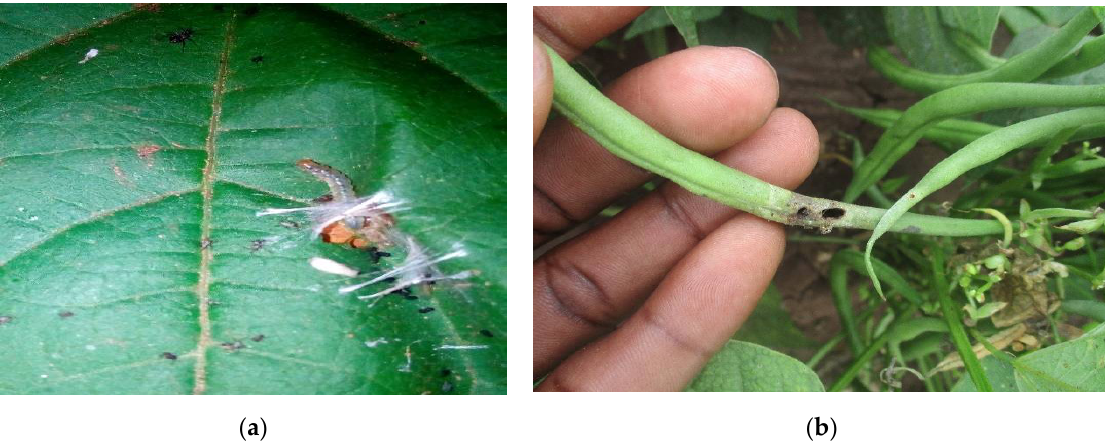
Figure 1. ( a ) M. vitrata larva and ( b ) pod damage by M . vitrata larva. Maruca vitrata infestation in beans (Photograph by Baltazar Ndakidemi, NM-AIST-Arusha, Tanzania). Table 2. Host plant species for Maruca vitrata and Aphis fabae . Bean